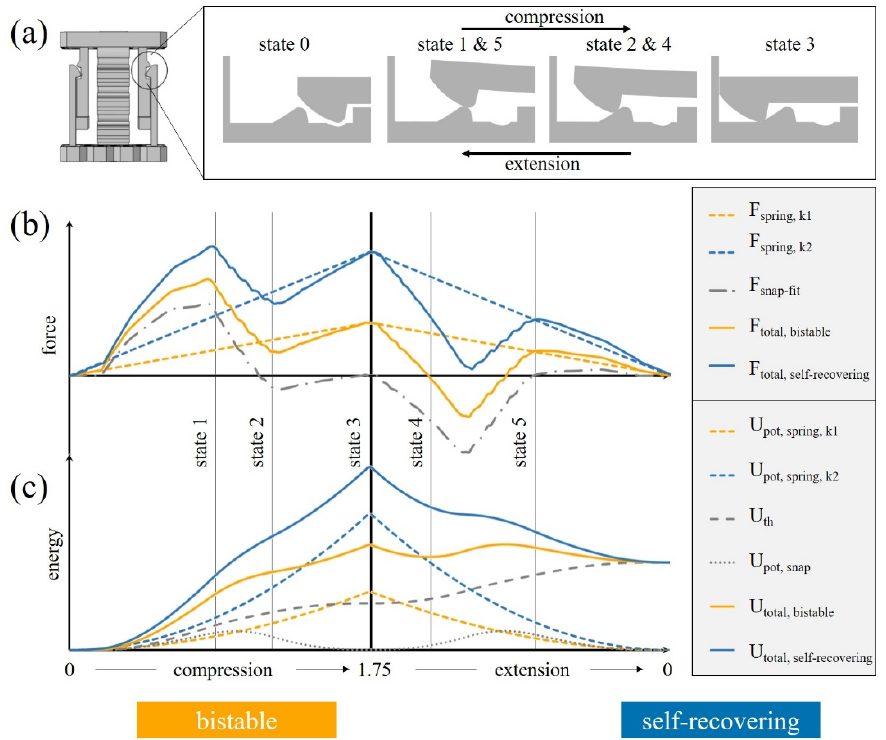
Figure 2. ( a ) Illustration of the deformation of the snap-fit between the fully relaxed position (state 0) and fully compressed position (state 3). Analytical model of the friction-based metamaterial for two exemplary unit cells with identical snap-fit properties and different spring width and spring constants k 1 < k 2 , resulting in a bistable (orange, spring k 1 ) and self-recovering (blue, spring k 2 ) unit cell. ( b ) Force–displacement curves of an exemplary snap-fit mechanism ( F snap-fit , dashed/dotted line), springs with different spring constants k 1 < k 2 ( F spring , dotted line), and the force superposition for the two unit cells ( F total , solid line). ( c ) Energy–displacement curves representing the potential and thermal energies ( U pot,spring , U pot,snap , and U th , dotted and dashed lines) and the resulting total absorbed energy ( U total , solid